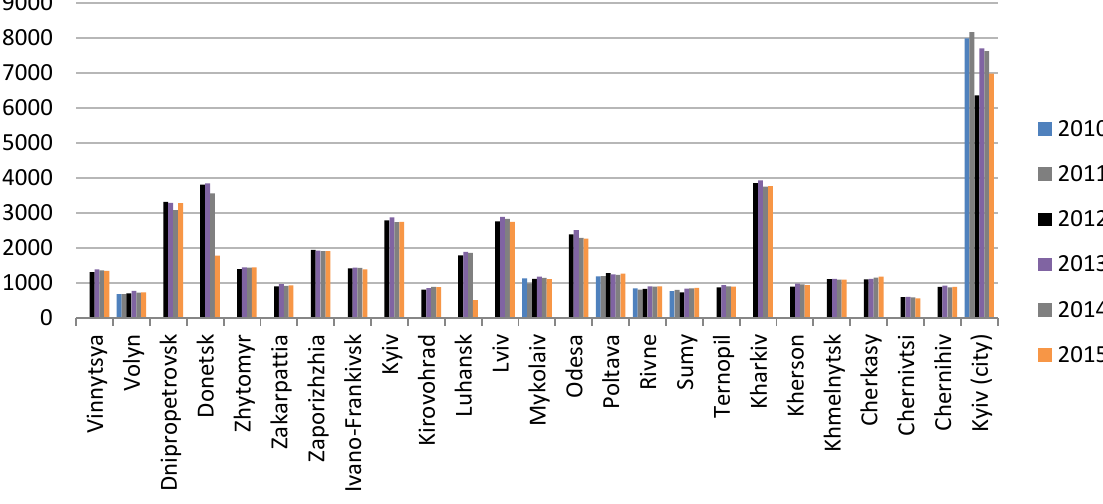
Fig. 9. The number of industrial enterprises by region in 2010 – 2015, units (based on data of the State Statistics Service of Ukraine)